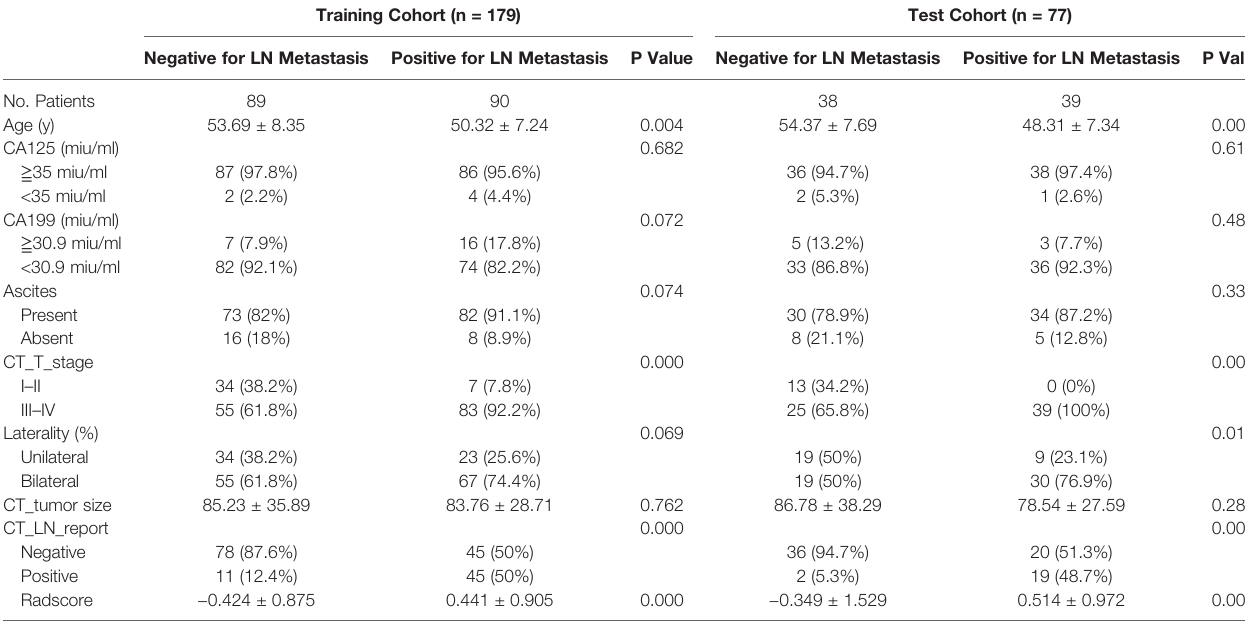
TABLE 1 | Clinical characteristics of the patients in the training and test cohorts. Training Cohort (n = 179) Test Cohort (n = 77)